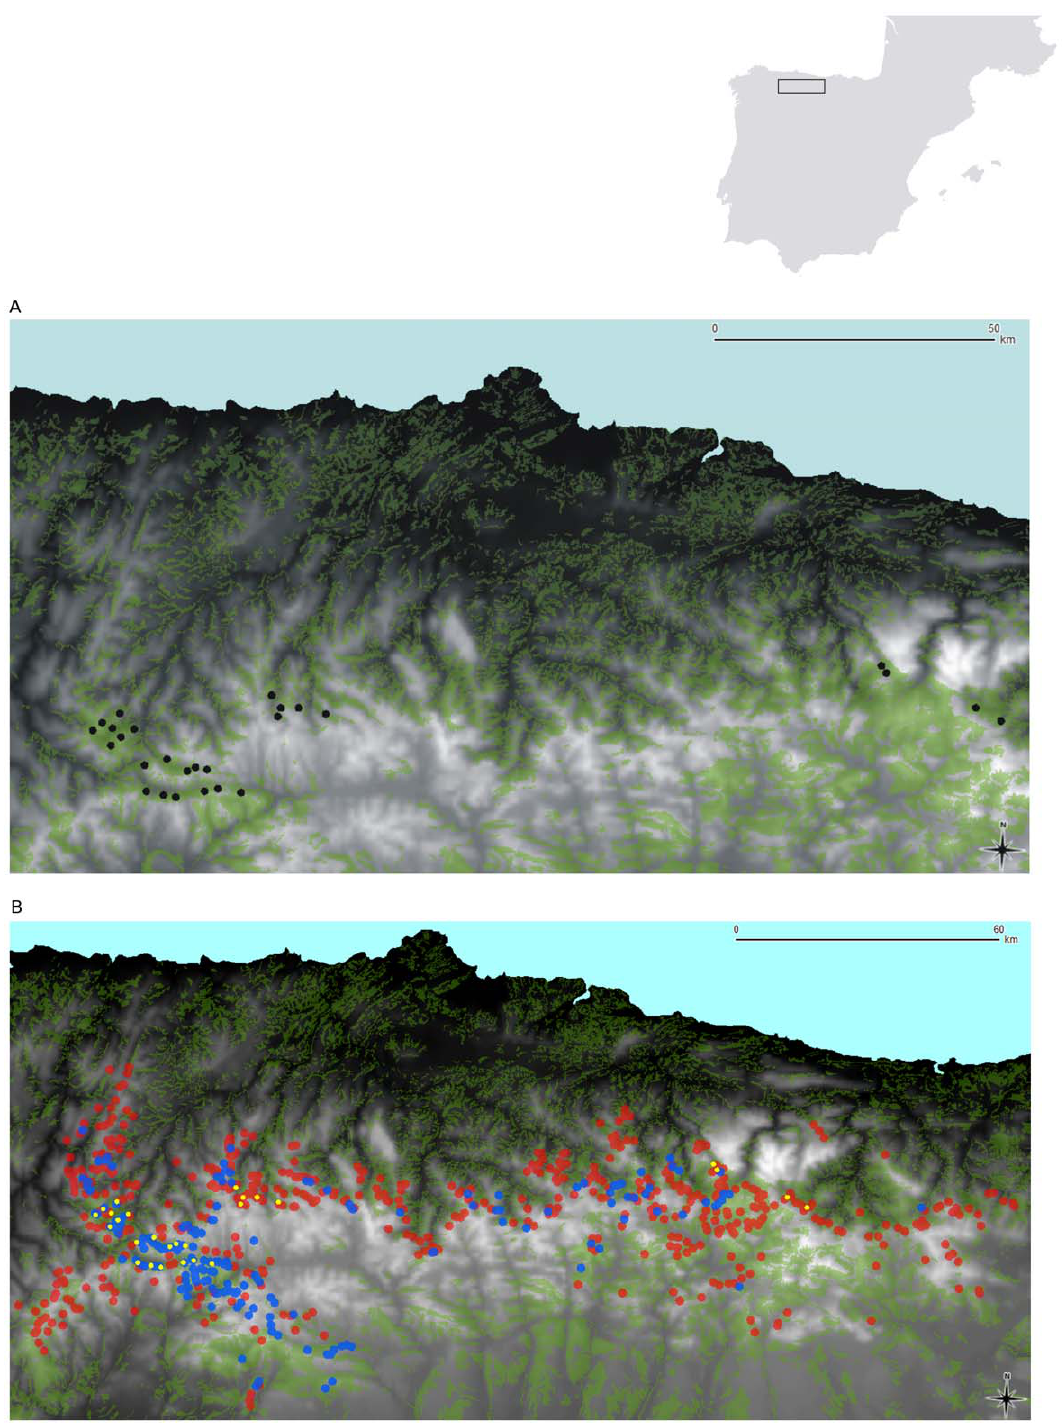
Figure 1. Study area and Capercaillie distribution in Cantabrian Mountains. (A) Location of the 27 study plots (black dots). Green areas represent wooded habitats, the grey colour scale denotes the altitudinal gradient (lighter at higher altitudes). (B) Capercaillie home ranges in 2005– 2006 (blue areas), abandoned plots (red areas) and study plots (yellow dots).